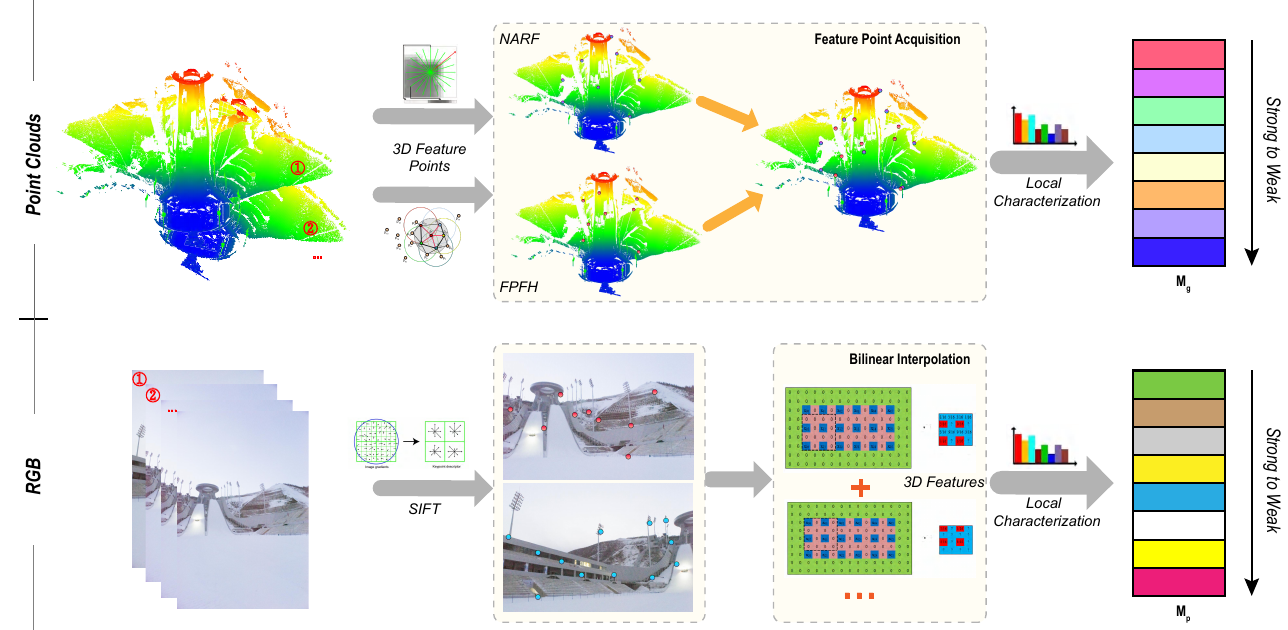
Figure 5. Feature matching point set. The NARF and FPFH algorithms are used to extract 3D feature points from the laser point cloud data in the dataset, respectively, and the feature matching point pair set M g is established based on the local feature description method. The 3D feature points are then extracted using SIFT and the bilinear interpolation method for RGB images, which in turn generates the set of point pairs M p